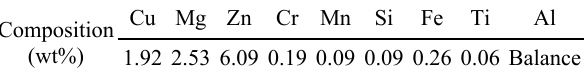
Table 1 Chemical composition of as-cast Al 7075